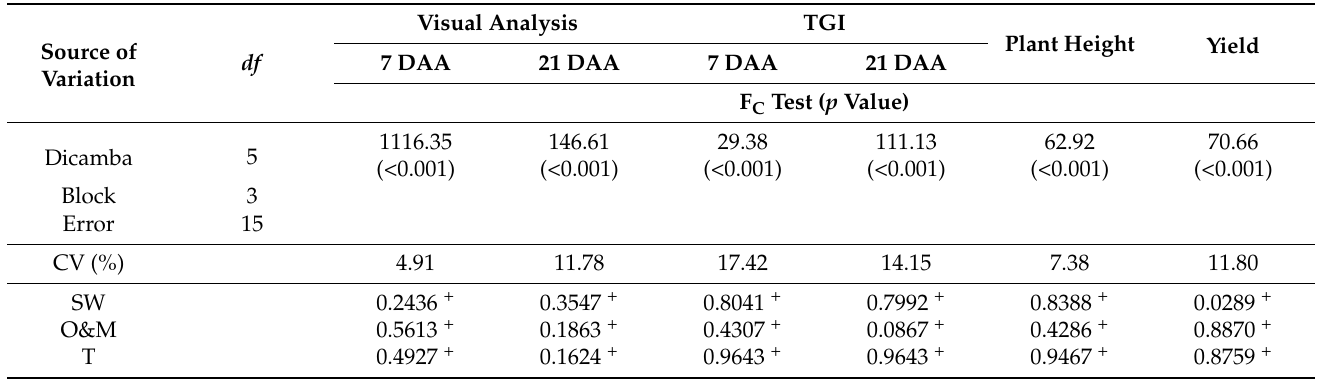
Table 1. Summary of the analysis of variance.